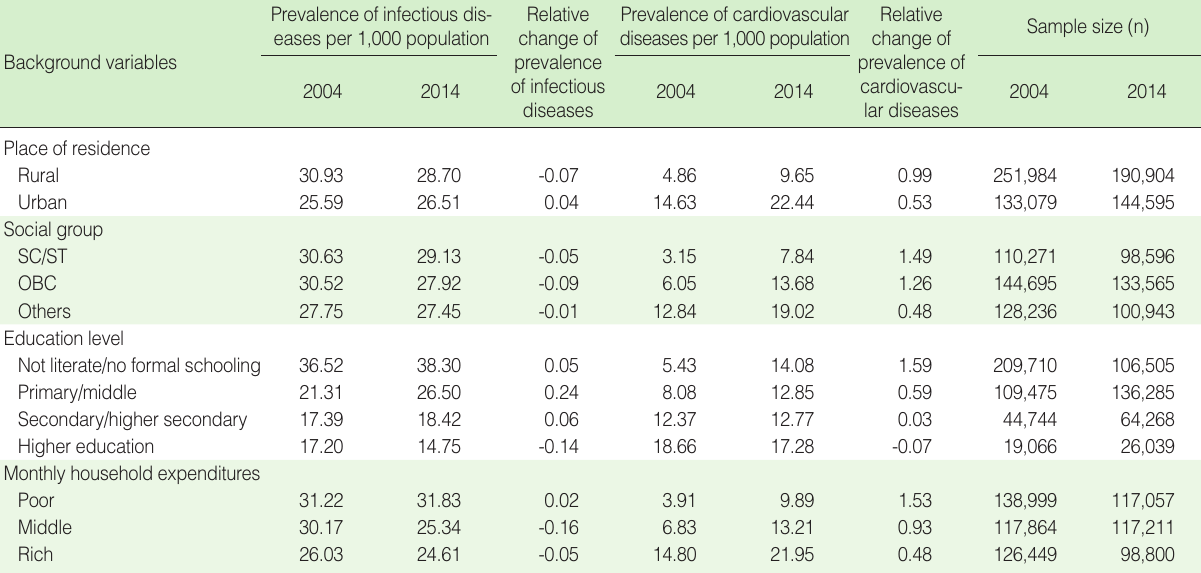
Table 3. Prevalence of infectious and cardiovascular diseases by background characteristics